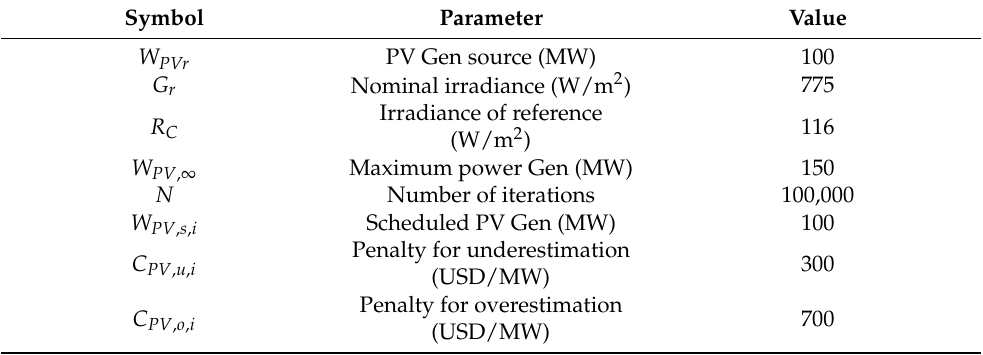
Table 2. Solar generation parameter, data from [34].